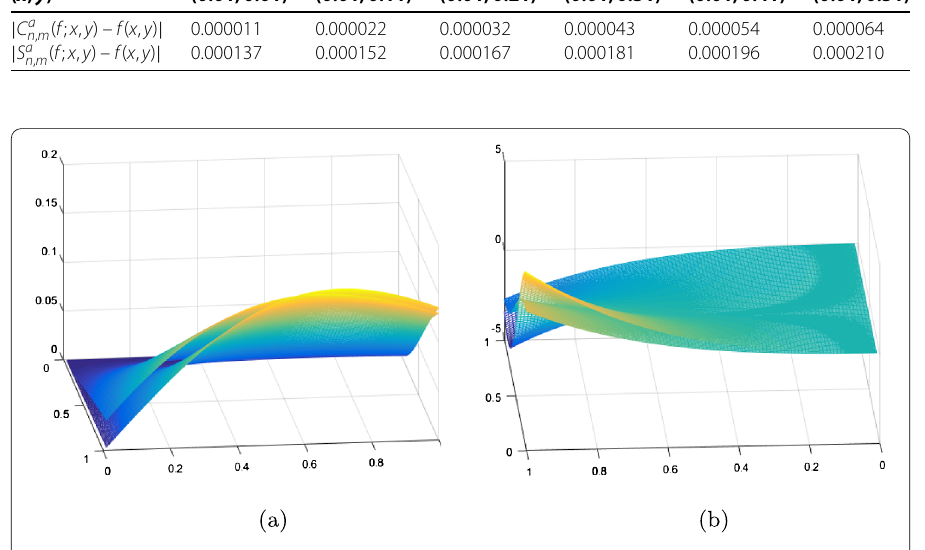
Figure 1 The convergence of the operators C a n ; m ( f ; x ; y ) to function f ( x ; y